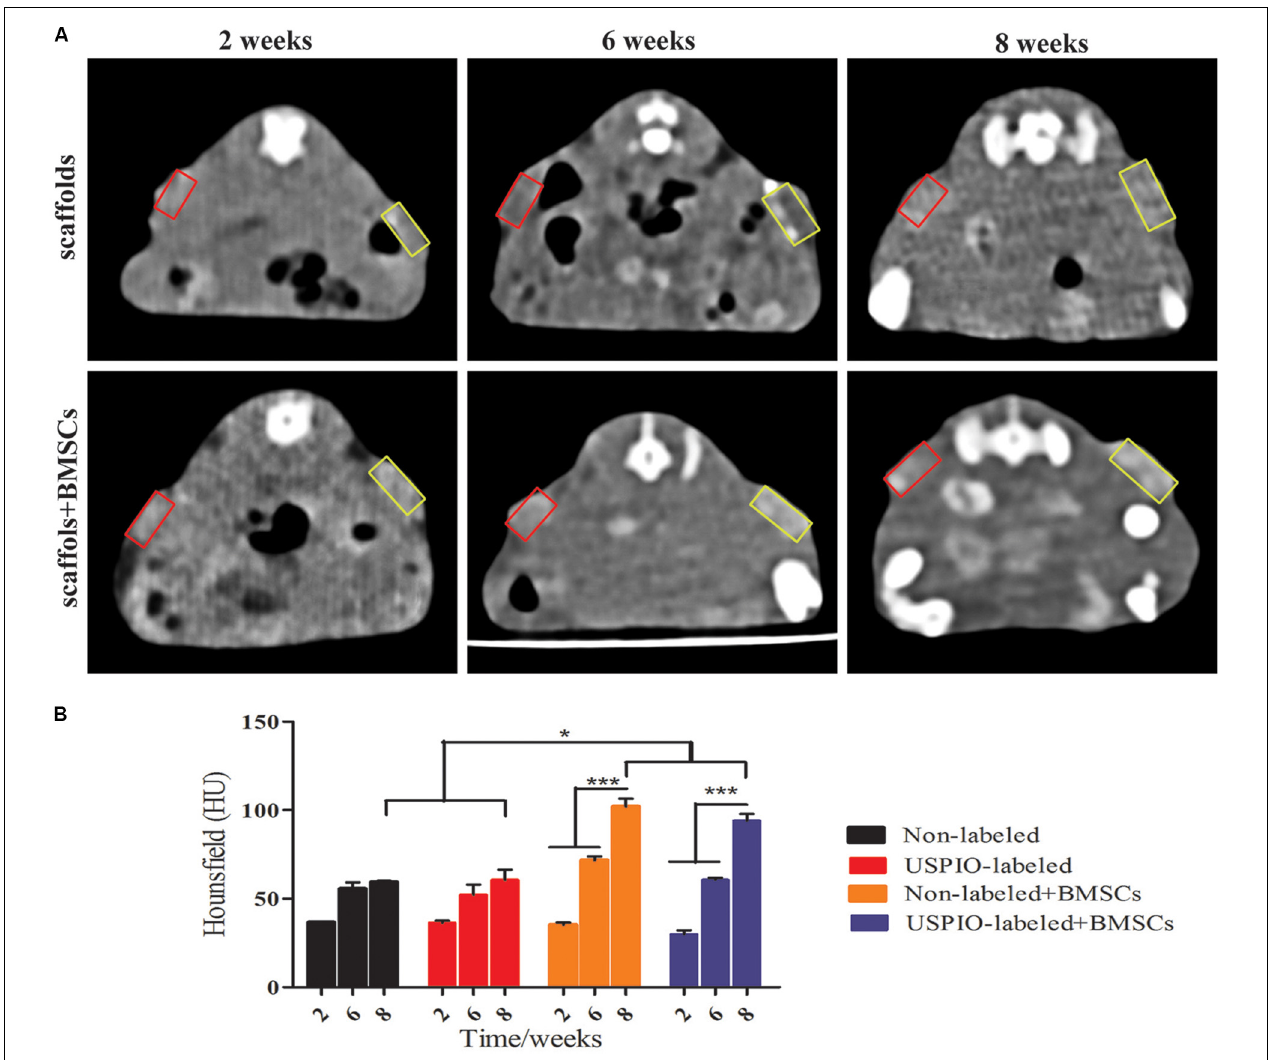
FIGURE 7 | CT analysis for in vivo studies. (A) CT images of mice show increased density over 2, 6, 8 weeks (yellow box: USPIO-labeled scaffolds, red box: non-labeled scaffolds). (B) CT values confirm subcutaneous bone formation of scaffolds (* P < 0.05, ** P < 0.01, or *** P <